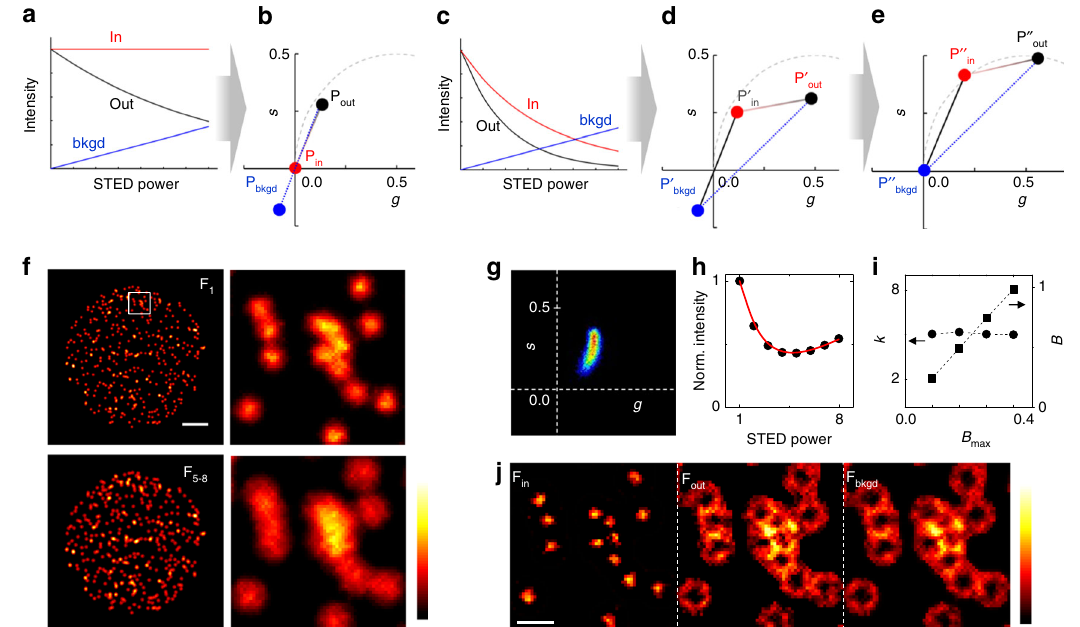
Fig. 4 M-STED in presence of STED-induced background. a Fluorescence depletion dynamics in the center (in) and in the periphery (out) of the PSF, together with STED-induced background (bkgd) along the stack, for the original M-STED con fi guration. b Phasor representation of dynamics depicted in a . P bkgd is co-aligned with the phasors P in and P out . c Fluorescence depletion dynamics resulting from the application of the modi fi ed version of M-STED, with modulation of both excitation and STED power as shown in the Supplementary Fig. 10. d Phasor representation of dynamics displayed in c . The photons originated in the center and the periphery of the PSF appear at new positions P ′ in and P ′ out , respectively, and thus the three phasor P ′ in , P ′ out , and P ′ bkgd are no longer co-aligned. e For SPLIT application purposes, the coordinates are changed such that the position of the background phasor moved to the origin position. f Simulated imaging of nuclear foci with the modi fi ed version of M-STED, where the excitation intensity is modulated as an exponential decay (see Supplementary Fig. 10). Color scale: normalized intensity. Scale bar: 3 µ m. g Phasor representation of dynamics encoded in f . h Average variation of the fl uorescence intensity as a function of the STED power. The red line is a fi t of Eq. (6) to the data. i Values of k and B retrieved from fi tting the depletion curves of M-STED stacks simulated at different levels of background (Supplementary Fig. 11). j SPLIT components F in , F out , and F bkgd , showing the ef fi cient separation of P ′ in , P ′ out , and P ′ bkgd . Color scale: normalized intensity. Scale bar: 500